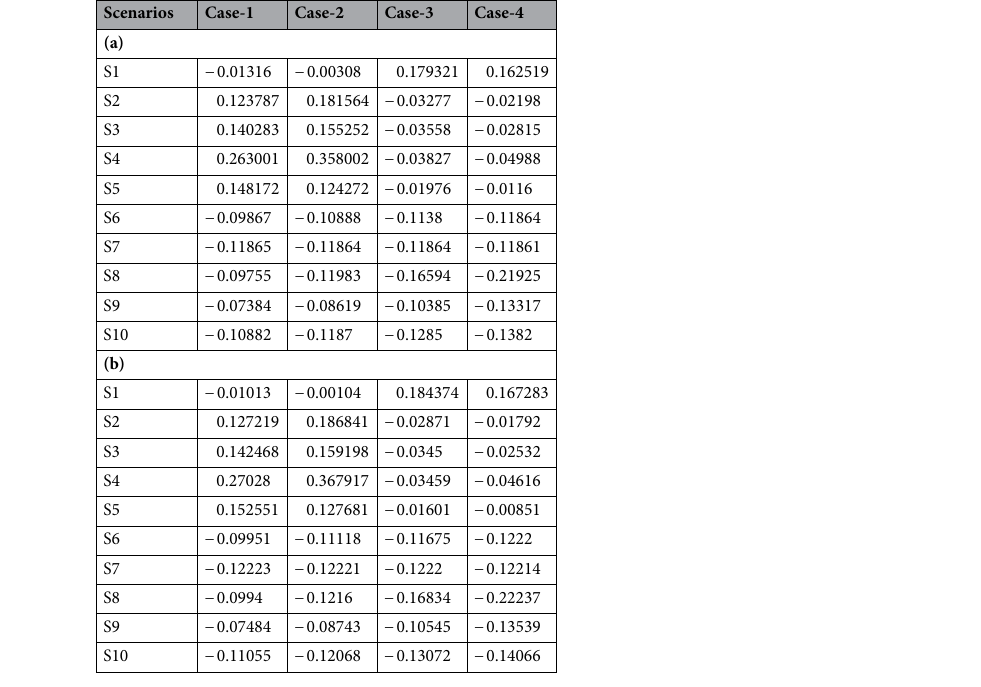
Table 8. Skin friction evaluated during different scenario and cases for (a) Copper nanoparticles, (b) Silver